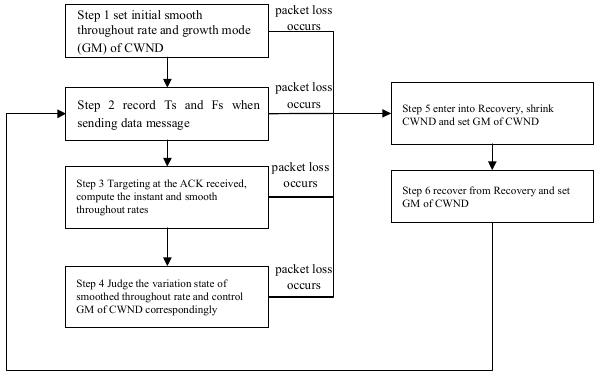
Figure 1. Flowchart of the BoostTCP congestion control algorithm.